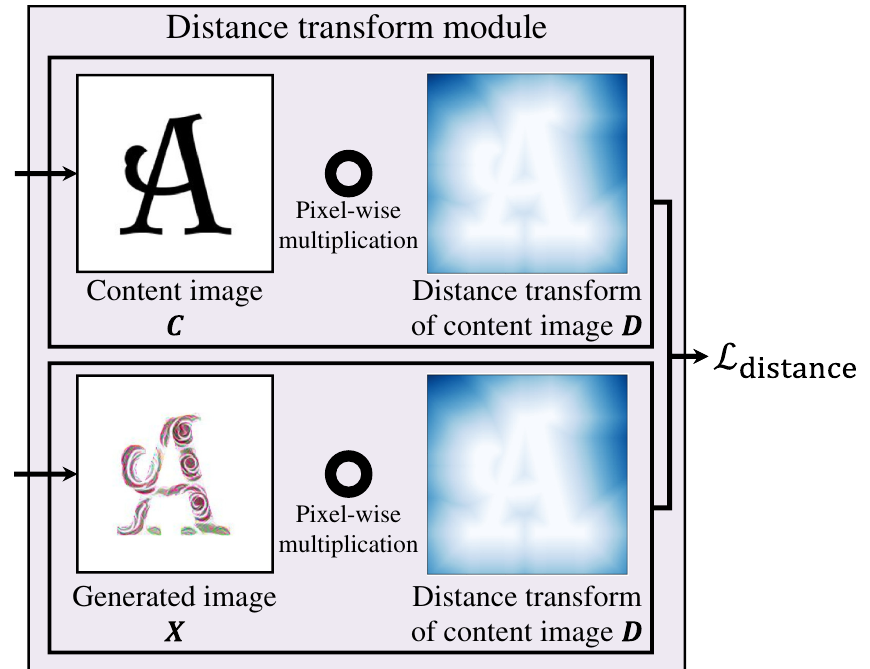
Fig 7. Distance transform module. Distance transform loss L multiplication of the content image C and D , and pixel-wise multiplication of the generated image X and D .